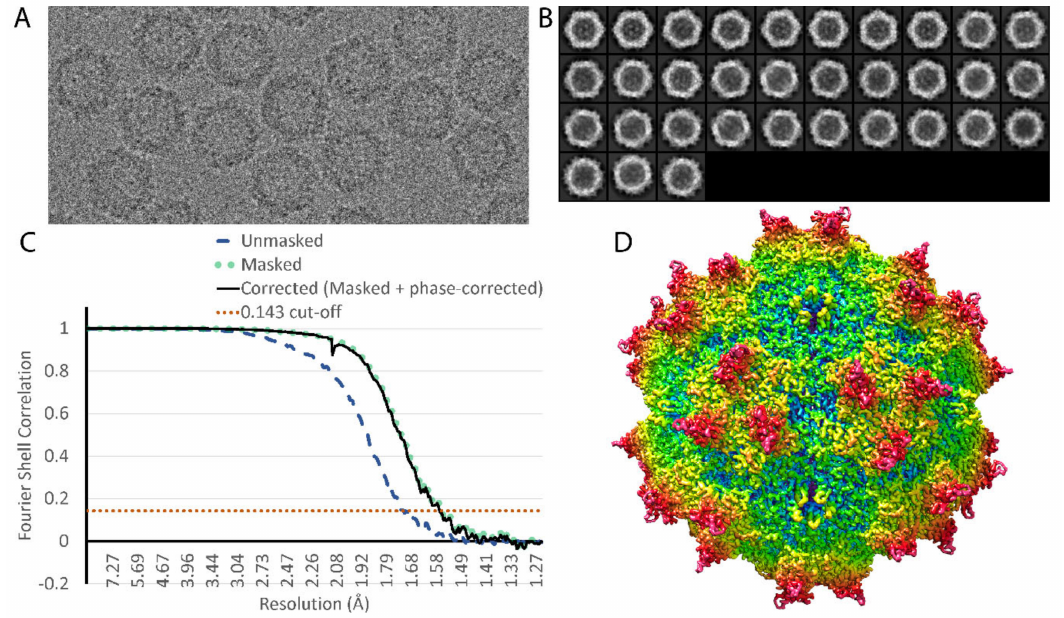
Figure 1. Cryo-EM reconstruction. ( A ) Motion-corrected image, integrated from frames; ( B ) 2D class averages calculated from 75,316 particles; ( C ) the gold standard FSC [47] gives an estimate of resolution at 1.56 Å; and ( D ) the reconstruction, rainbow colored according to distance from the center of the particle. The view is along a 2-fold symmetry axis. Spikes surrounding each 3-fold axis can be seen left and right of center, and 5-fold pores can be seen above and below